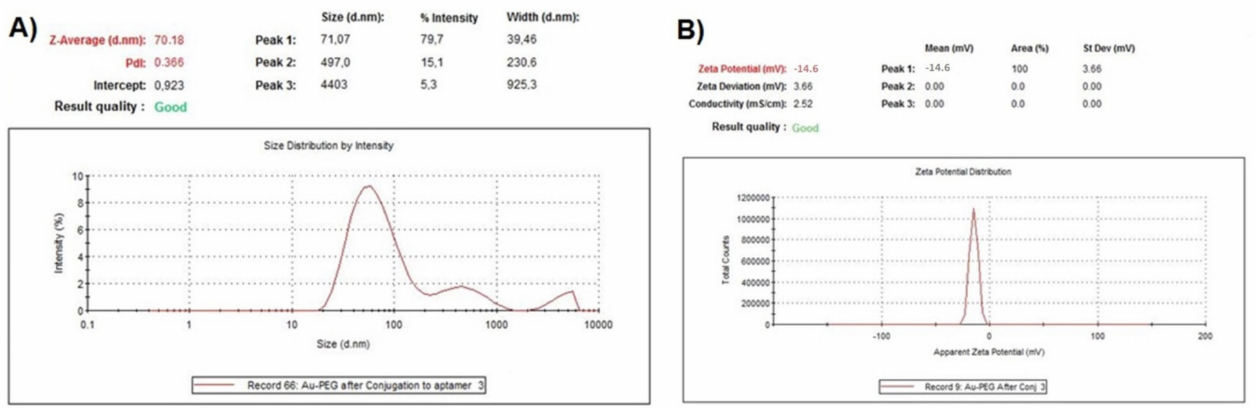
Figure 3. Characterization of Au-PEG-CD133 ( A ) DLS with a significant change in the size and without any agglomeration and ( B ) Zeta potential with no significant changes, which was expected.